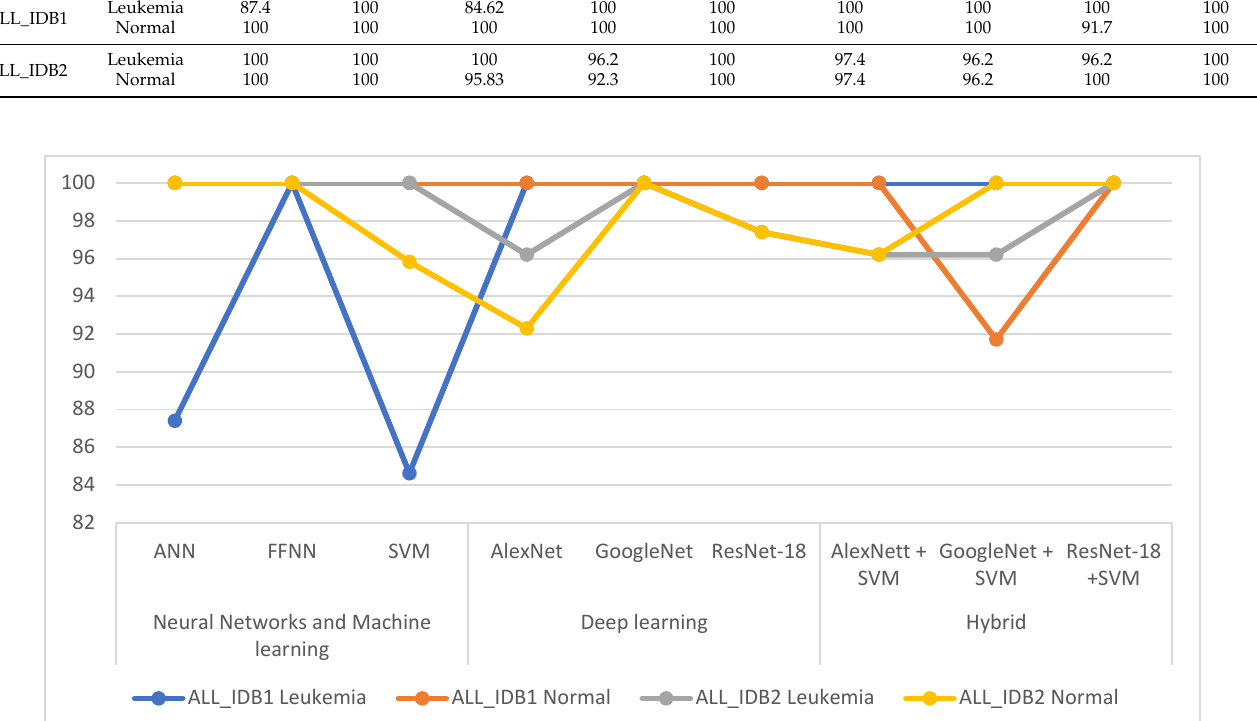
Figure 29. Comparison of the performances of the proposed systems for diagnosing leukemia from the two datasets.